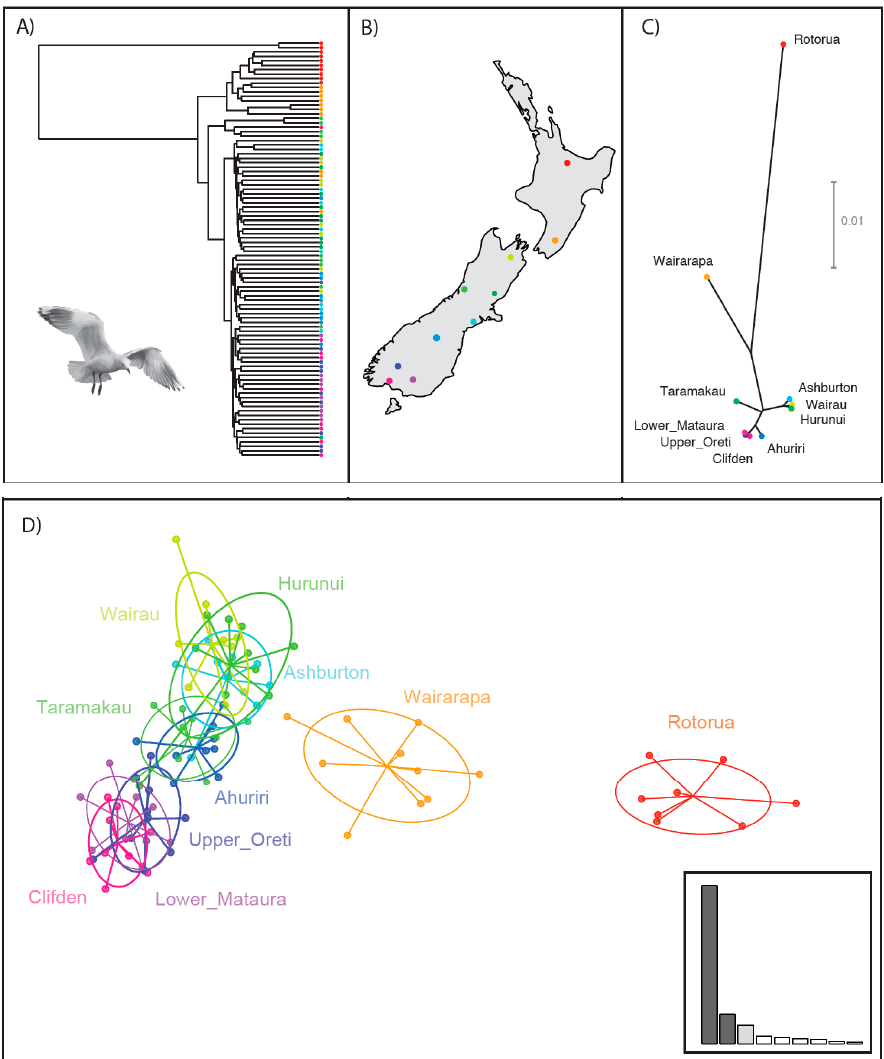
Figure 3 . ( A ) Neighbour-joining tree of black-billed gulls from across New Zealand using SNPs based on relatedness estimates derived from Kinship using GBS with Depth adjustment (KGD). Colours correspond to location of sampled catchments in map inset ( B ). ( C ) Unweighted Pair Group Method with Arithmetic Mean (UPGMA) tree showing population divergence of black-billed gulls in New Zealand as measured by F ST from SNPs. ( D ) Discriminant analysis of principal components (DAPC) scatterplot of SNPs from 10 black-billed gull colonies sampled across New Zealand. Individuals are shown as dots with the majority grouped within ellipses. Inset shows the proportion of variation accounted for by each PC.